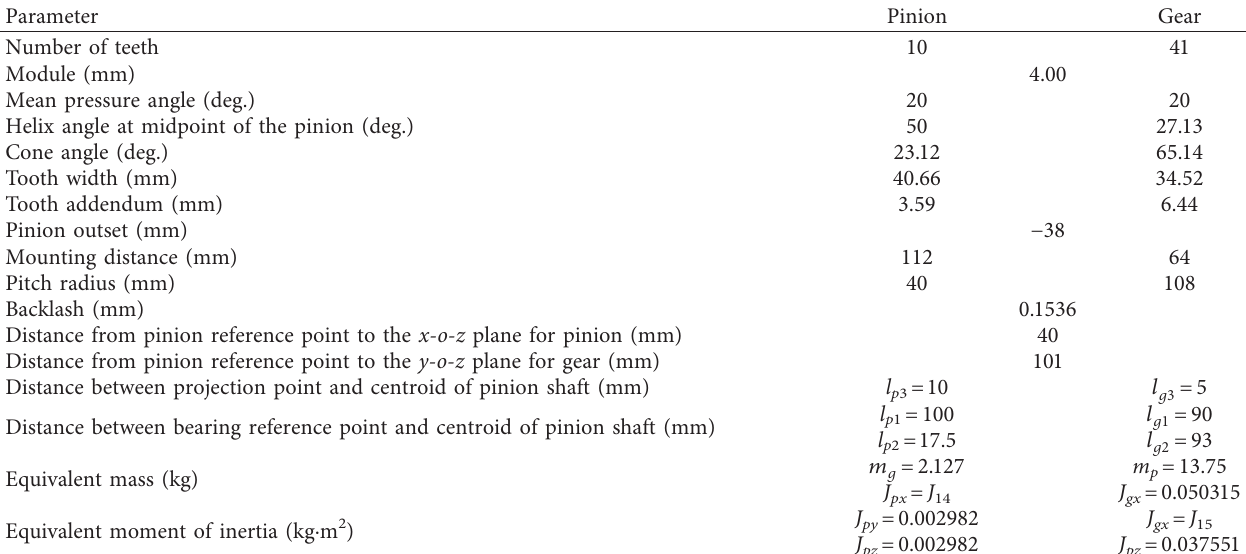
Table 2: The system parameters of the main reducer.